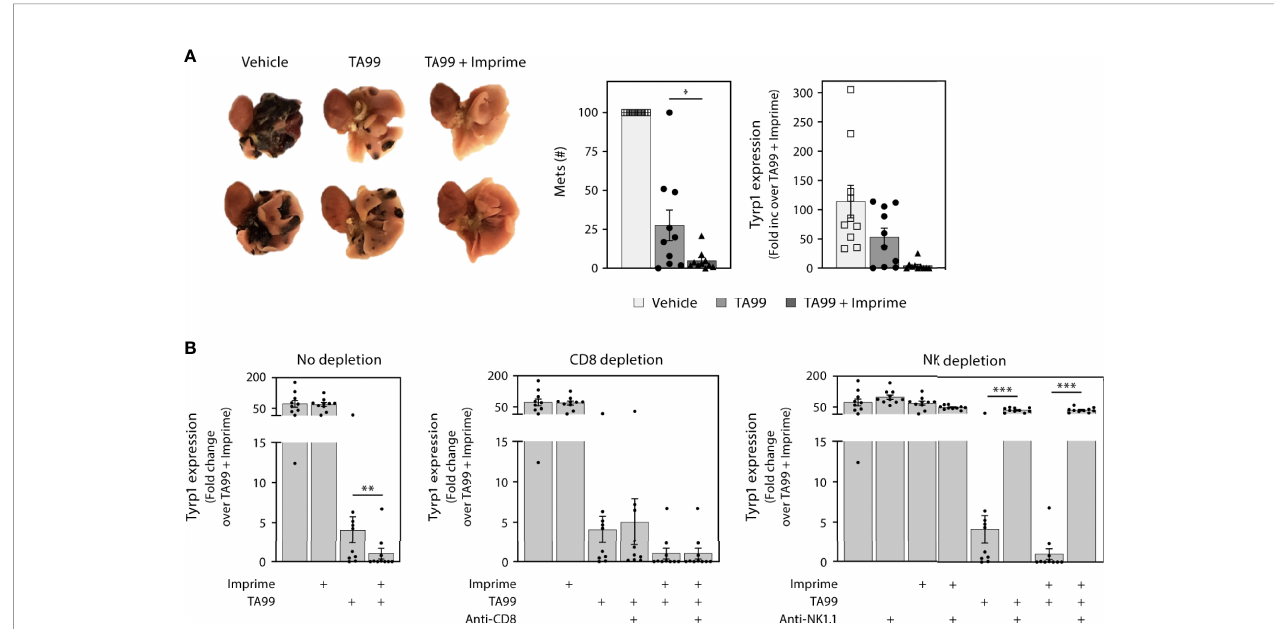
FIGURE 7 | Imprime in combination with a tumor-targeting mAb inhibits formation of melanoma metastases. One x 10 5 B16F10 cells were administered i.v. to naïve C57BL/6 mice (n = 10 per treatment group), and treatments were administered as described in Materials and Methods. Mice were euthanized on day 21 and lungs were removed. (A) Representative picture of day 21 mouse lungs from different treatment groups; two samples from each treatment group are shown. The number of metastases (mets) in the lungs were counted or evaluated by quantitative RT-PCR using Tyrp1 expression. (B) Relative expression of Tyrp1 message in the day 21 lungs, upon CD8 T cell depletion or NK depletion. Representative results from 2 experiments are shown. All summary data are presented as mean ± SEM. One- way ANOVA and Tukey multiple comparison was used in (A, B) . * p < 0.05, ** p < 0.01, *** p <